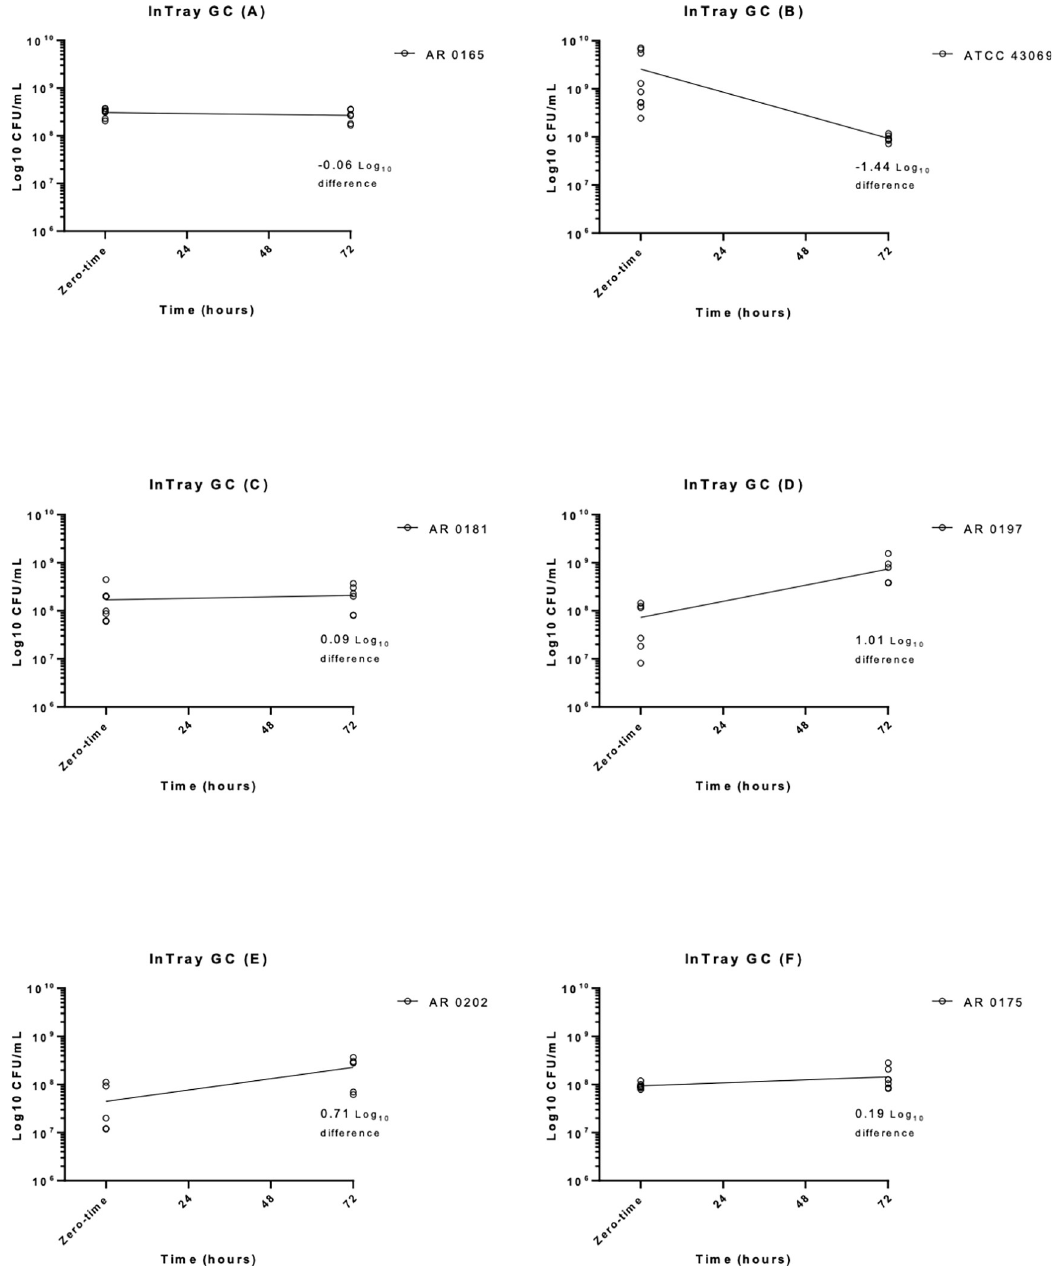
Fig 2. Time in hours versus Log 10 CFU/mL for the InTray GC for all six strains. CFU; colony forming units.